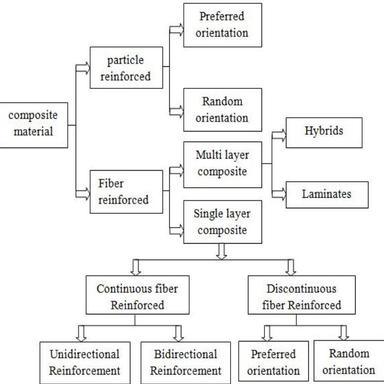
lassification of composite materials